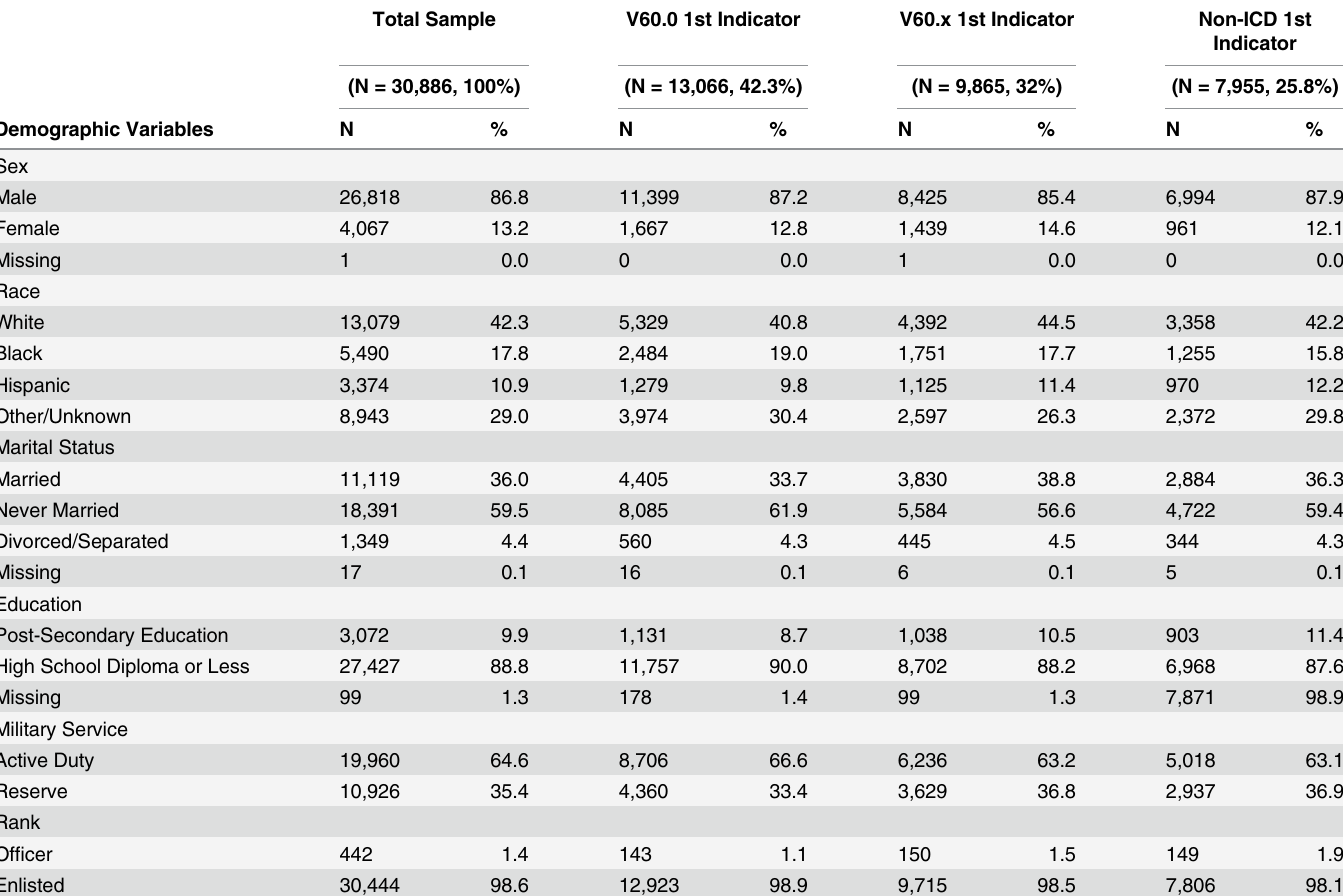
Table 2. Characteristics of Veterans of Operations Enduring Freedom/Iraqi Freedom/New Dawn (OEF/OIF/OND) according to “ first indicator of homelessness ” group during fiscal years 2001 – 2012; N = 30,866. Note. All demographic variables differed significantly across 1 st homelessness classifi- cation groups following chi-square tests, all p <